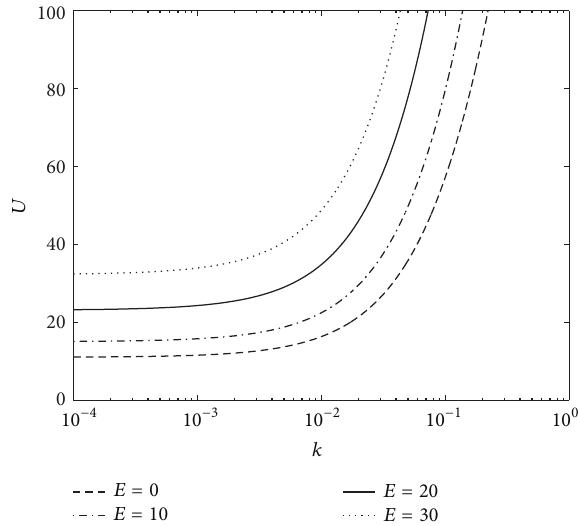
Figure 4: The neutral curves of velocity ratio for the different values of electric field intensity when 𝑊 = 100 , 𝜇 = 0.018 , 𝜌 = 0.0012 .